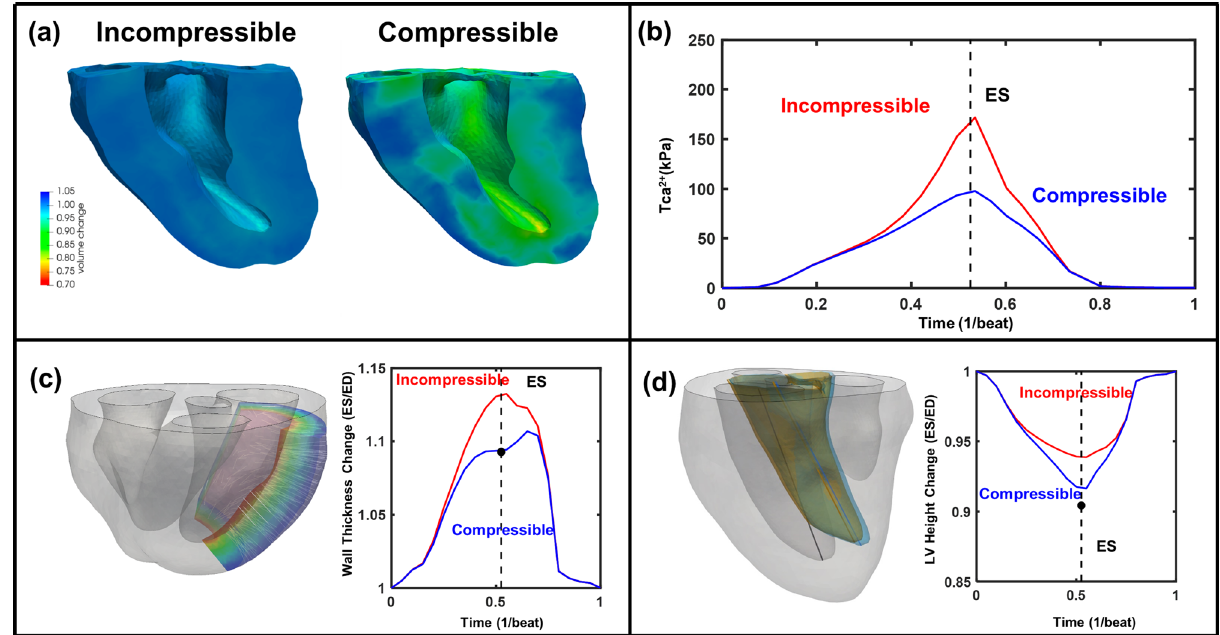
Figure 4. ( a ) Comparisons of predictions in volume change (end-systole) between the compressible and incompressible models, ( b ) T Ca 2 + fitted by the compressible and incompressible models, ( c ) LV free wall (LVFW) thickness change distribution for compressible and incompressible models, and black dot in end-systole means validation point from sonocrystal study, ( d ) LV height measured from the compressible and incompressible models. The black dot at end-systole represents the validation data point from in-vivo 2D